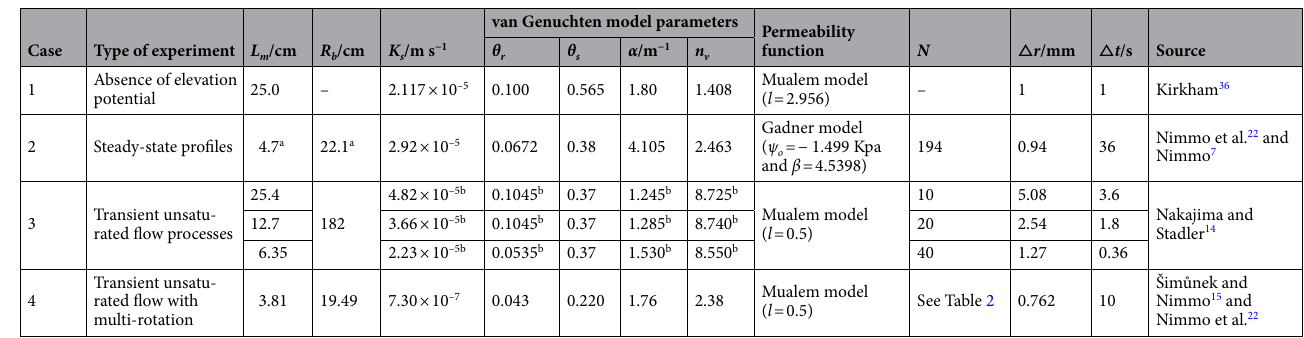
Table 1. Summary of simulation parameters for Cases 1–4. a Not directly give in the paper, but get from the figure of it. b Mean values of the two parallel experiments listed in Nakajima and Stadler 14